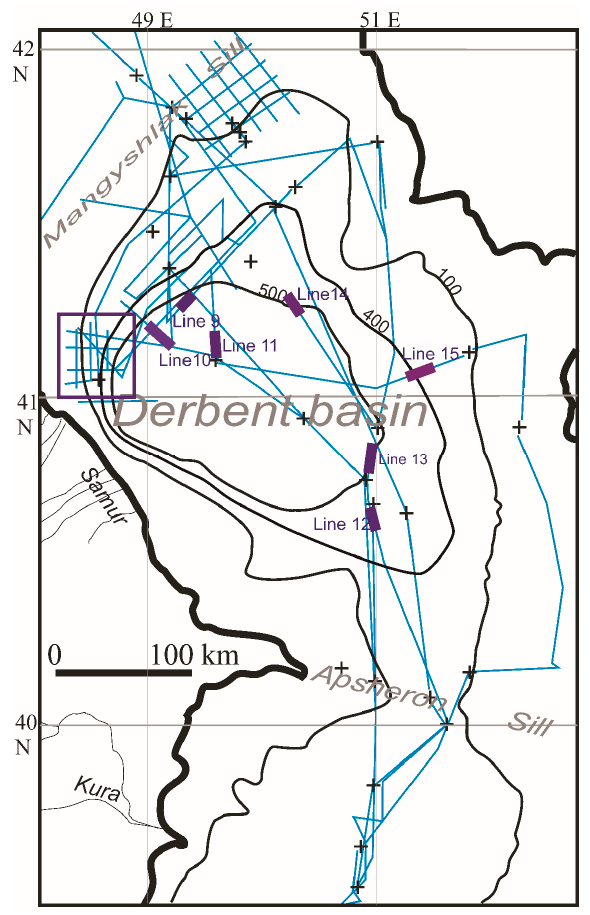
Figure 2. Scheme of seismic reflection profiles (high (sparker) and ultra-high (SES) resolution), collected by Shirshov Institute of Oceanology from 2004 to 2012. The straight lines show the positions of the seismic profiles illustrated in Figures 3–15. The rectangle shows the position of the seismic profiles shown in Figure 4. Crosses for oceanology stations. This paper focuses on the bottom and sub-bottom features in the central part of the Caspian Sea (the Middle Caspian) and the processes of near bottom water circulation which formed these features. Our main objectives are (1) to test the contourite paradigm on special sea-lake conditions, where the morphology is similar to an oceanic one, but all oceanography processes occur in far smaller time-space scale, and (2) to explore potential geohazards of which contouritic features can be signs.